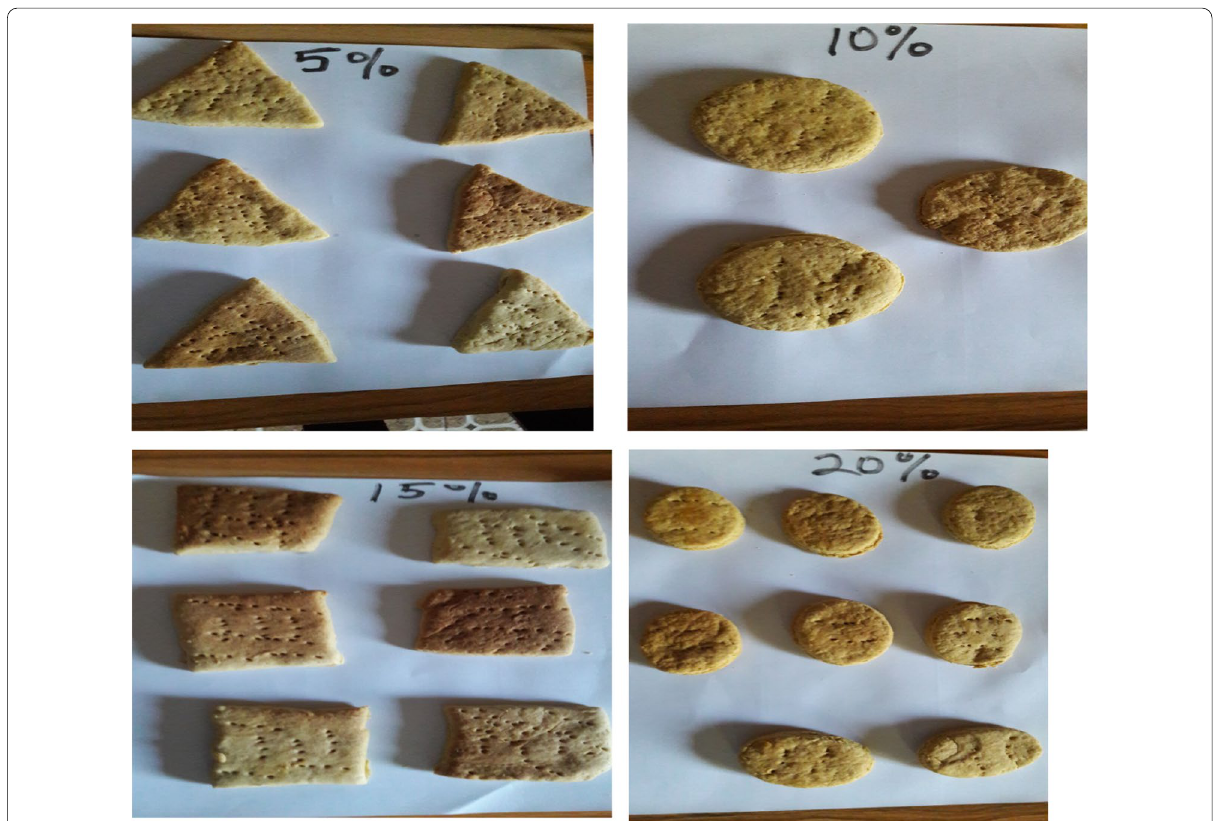
Fig. 17 Biscuits samples produced with 5%, 10%, 15% and 20% of wheat–tacca flour, respectively. TEB (5%): Rats fed with 5% enzymatic tacca flour 95% wheat flour biscuit, TEB (10%): Rats fed with 10% enzymatic tacca flour + enzymatic tacca flour